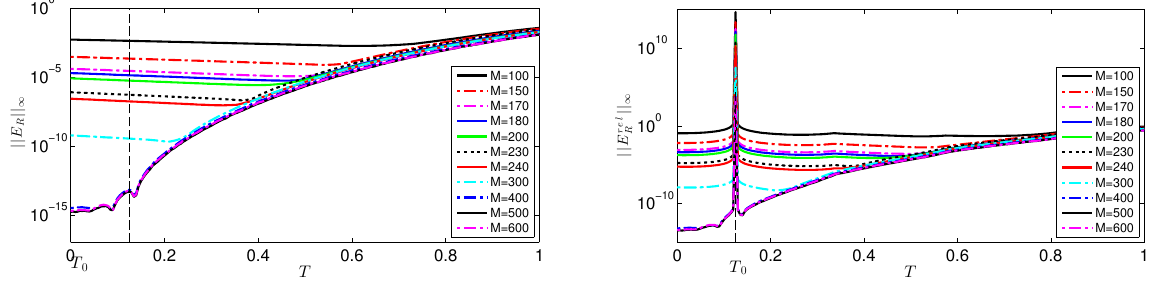
|| Figure 14. Left panel: || E in Dawson’s integral example as M varies. The vertical R ∞ = 0 . 125 . Right panel: evolution of the relative error dashed line indicates the time delay T 0 || E rel || in Dawson’s integral example as M varies. The vertical dashed line indicates the ∞ R = 0 . 125 time delay T 0